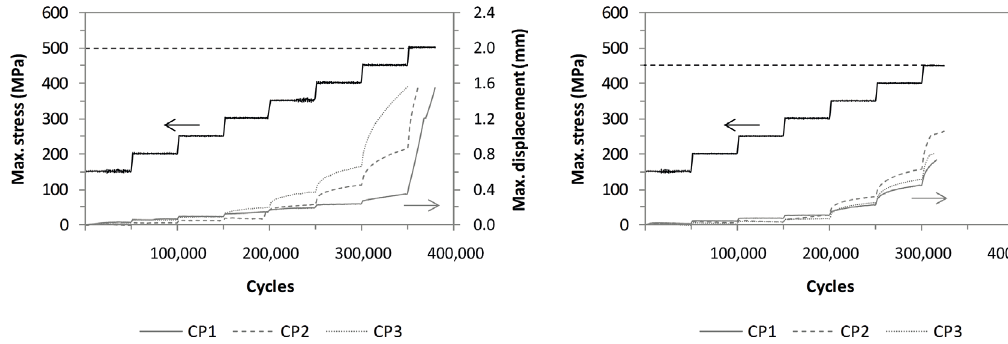
Figure 4. Stepwise load increase plot for the specimens annealed at 650°C.